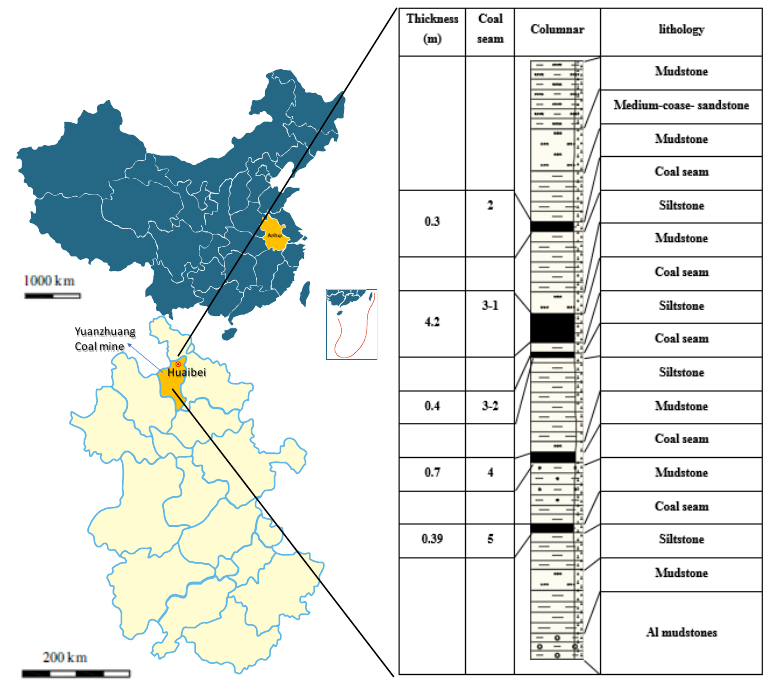
Figure 2. Location and geologic column of the Yuan Zhuang coal mine. Table 1. The main characteristics related to the coal’s quality.